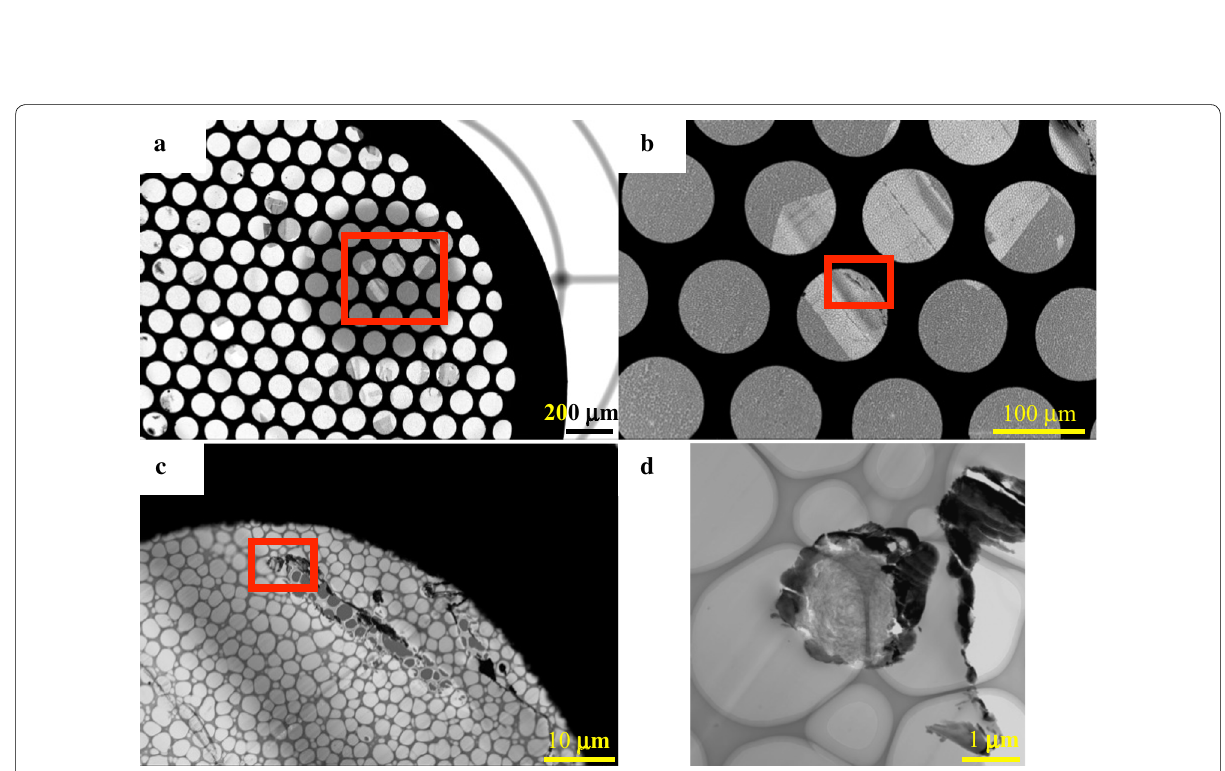
Fig. 3 TEM Observations. a Microtomed sections deposited on TEM grids. b , c A graphite found on one end of the carbon fiber. d TEM observations of the